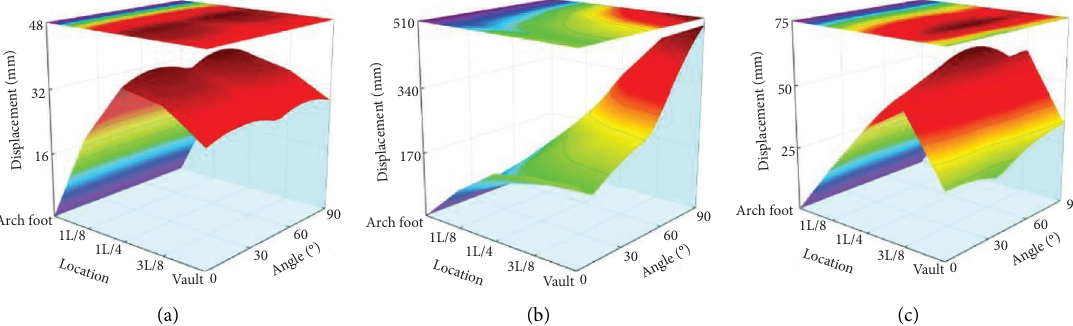
Figure 12: Upper chord displacement diagram for N max working condition under X + Y combined excitation. (a) X direction, (b) Y direction, and (c) Z